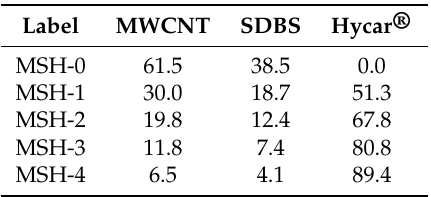
Table 2. Labels and compositions (wt. %) of MWCNT inks on a dry basis.